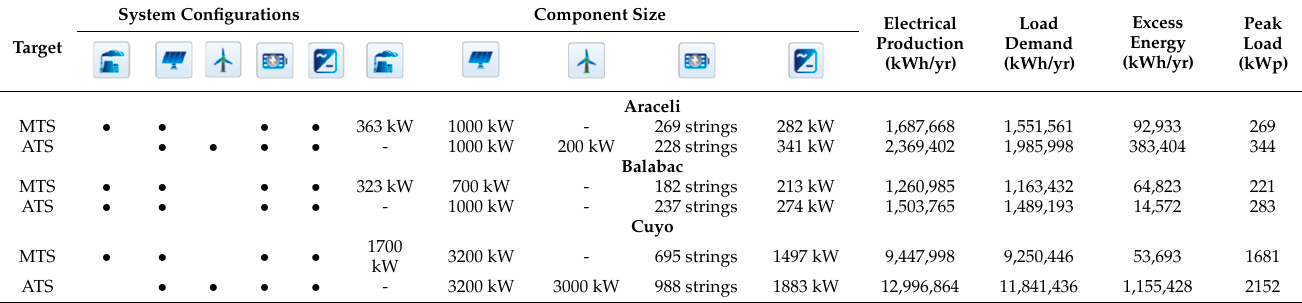
Table 4. Simulation results of the HOMER analysis in different configurations for MTS and ATS. System Configurations Target